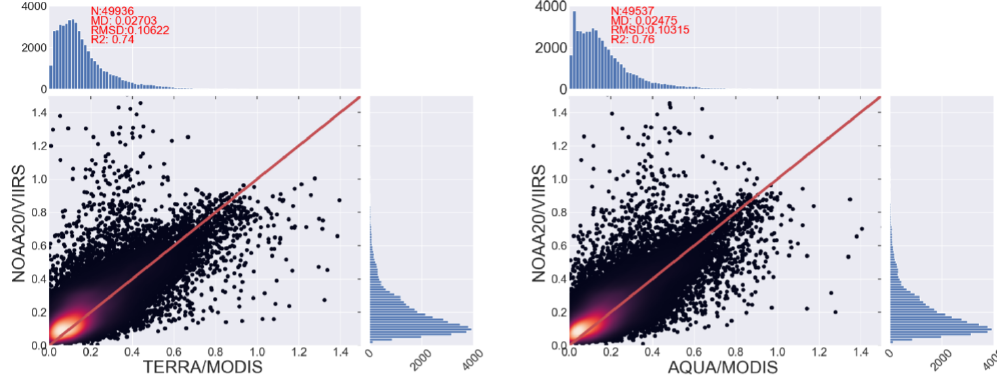
Figure B7. NOAA20/VIIRS vs. MODIS AOD scatter plots of temporal mean AOD over land for the DJF period.